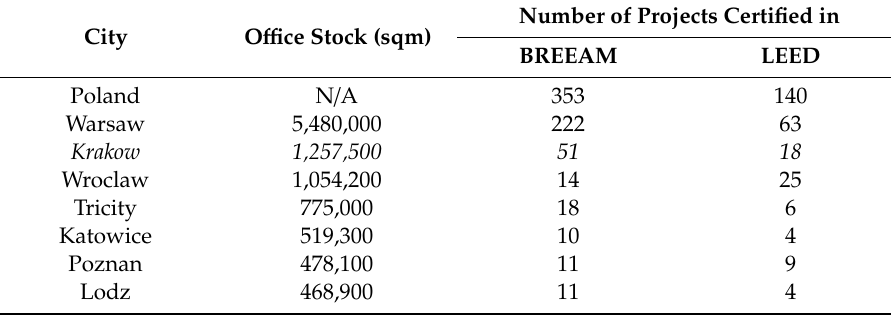
Table 2. O ffi ce buildings projects certified in BREEAM and LEED in Poland in 2019.